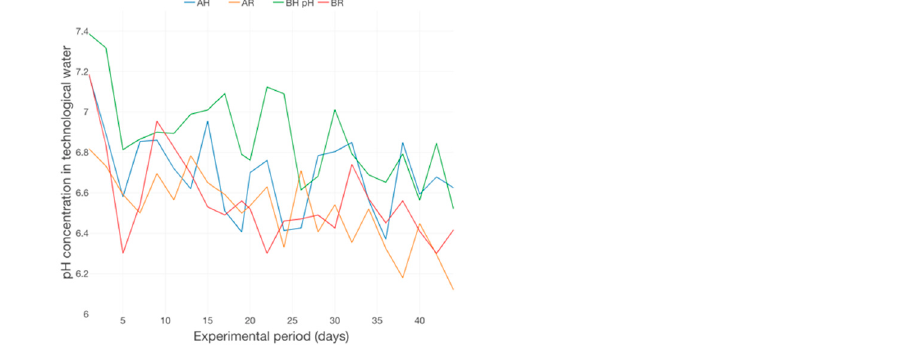
Figure 22. The dynamics of pH in technological water for each of the experimental variants.